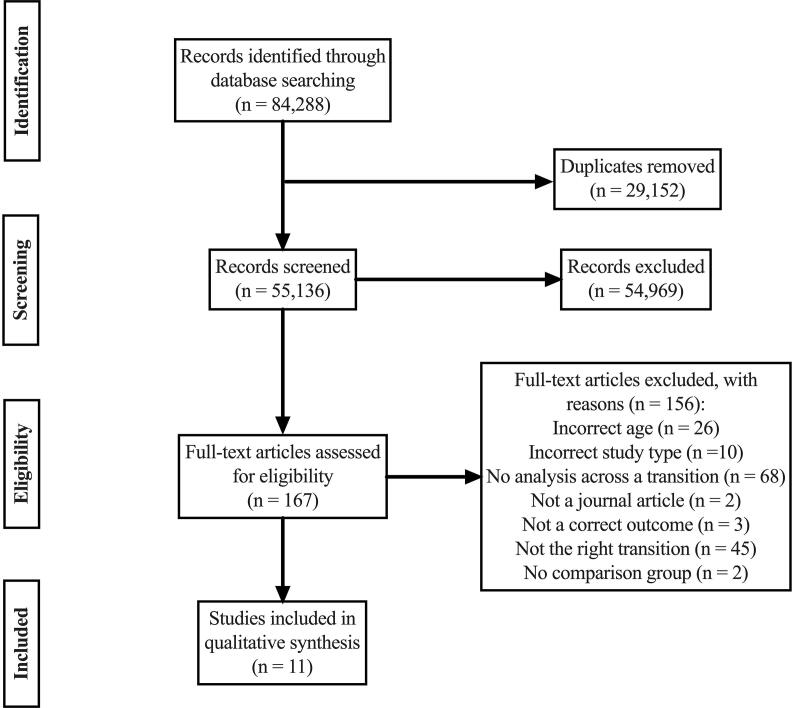
PRISMA flow diagram.